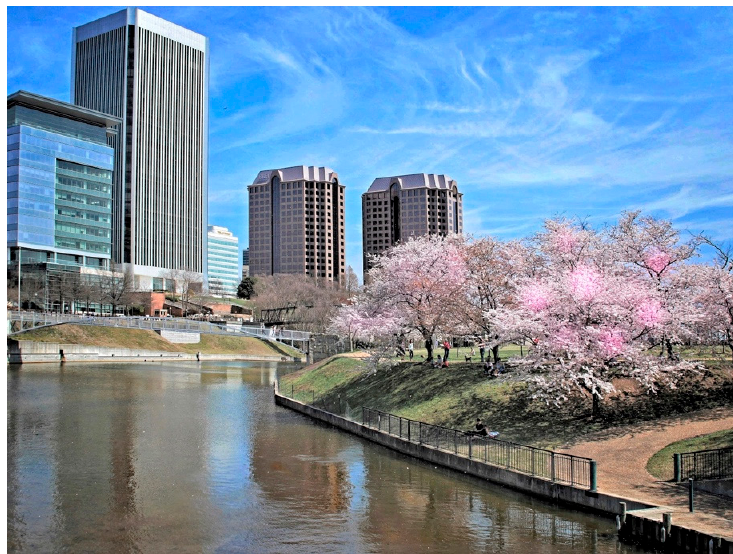
Figure 8. Urban landscapes can vary a lot in the deep meaning they convey, some of which may be negative deep meaning. Urban deep meaning often has an architectural component that conveys deep meaning about the activities that occur there. In the photo above, the juxtaposition of the water and green space with the office buildings conveys deep meaning of successful, progressive businesses as well as pleasant places to walk and escape the fast-paced business environment. (Titled “Cherry Blossom Time in Richmond” by Nancy Helms, courtesy of Scenic Virginia.)